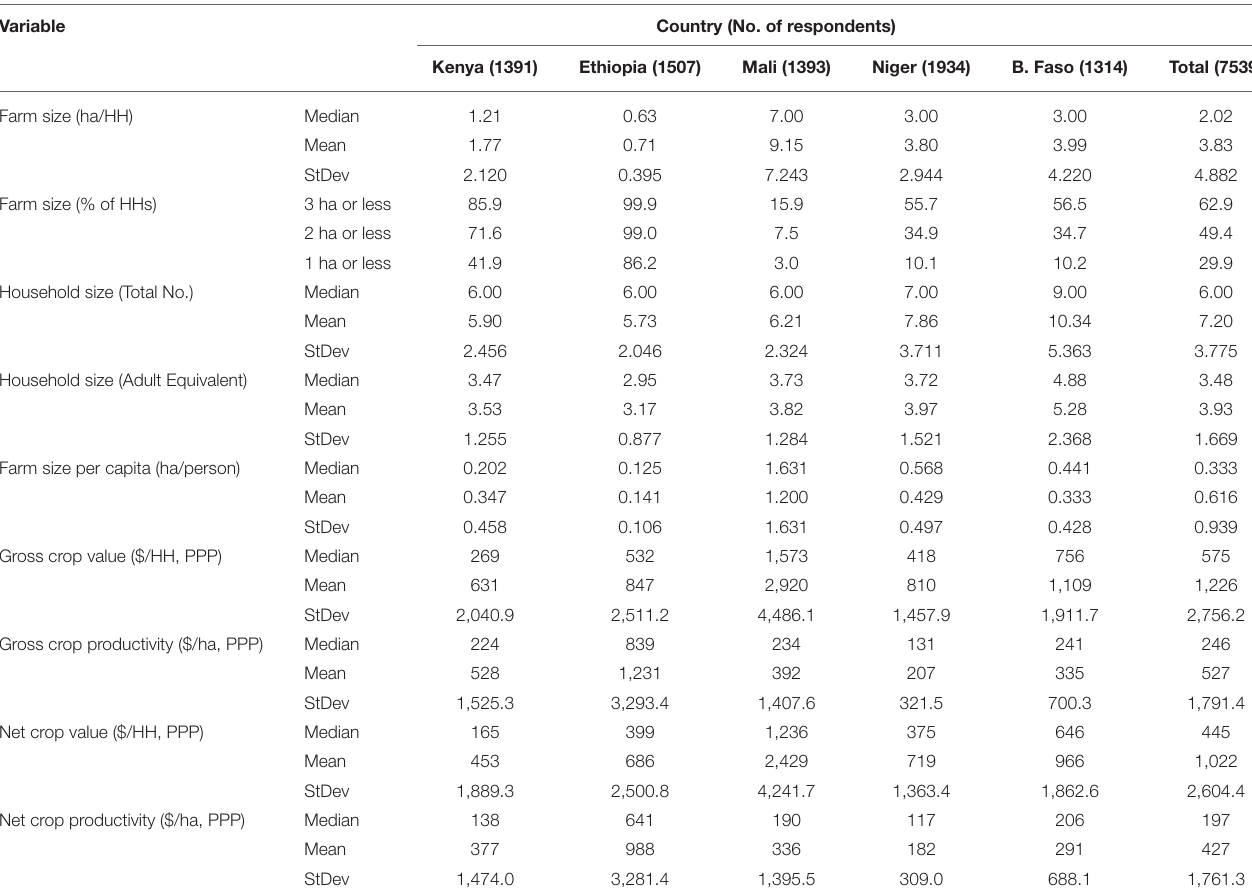
TABLE 1 | Farm size, household size, and crop performance.